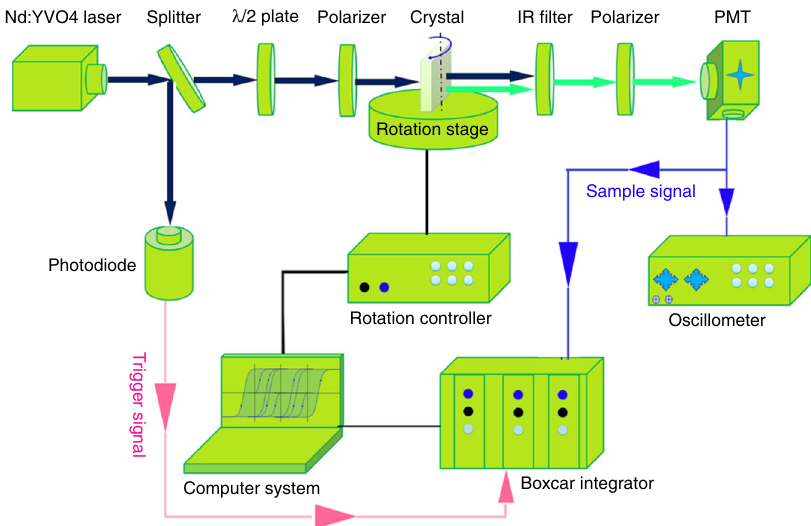
Fig. 5 Schematic diagram of the Maker fringe experiment using an Nd:YVO 4 laser. A Q-switched Nd:YVO 4 laser system was adopted as fundamental light source with the following experimental conditions: fundamental wavelength: 1064 nm; repetition frequency: 10 kHz; and pulse width: 10 ns. The second- harmonic signal, which changed with rotation angle of Pna 2 1 -Ba 3 Mg 3 (BO 3 ) 3 F 3 crystal, was detected by a photomultiplier tube, averaged by a fast-gated integrator and boxcar integrator, and then recorded by computer system. The Pna 2 1 -Ba 3 Mg 3 (BO 3 ) 3 F 3 crystal is at the waist of the fundamental light with a beam diameter of 1.0